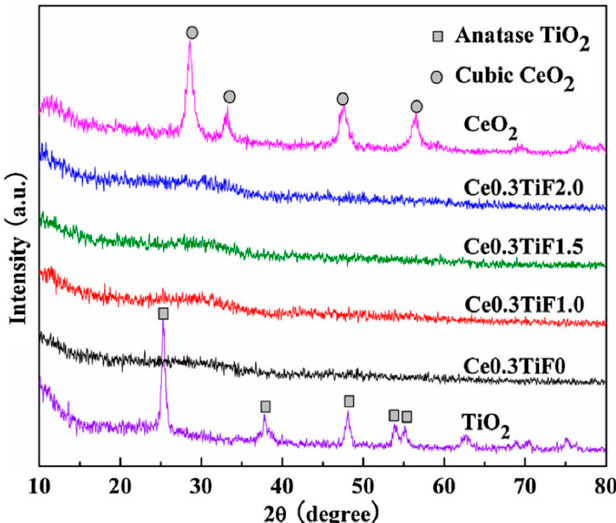
Figure 25. X-ray diffraction patterns of the Ce 0.3 TiF y , TiO 2 and CeO 2 [94].